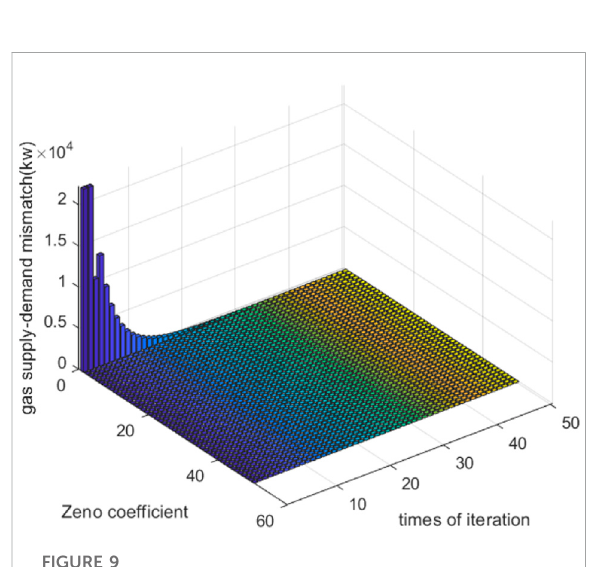
FIGURE 9 Convergence procedure of gas supply-demand mismatch.